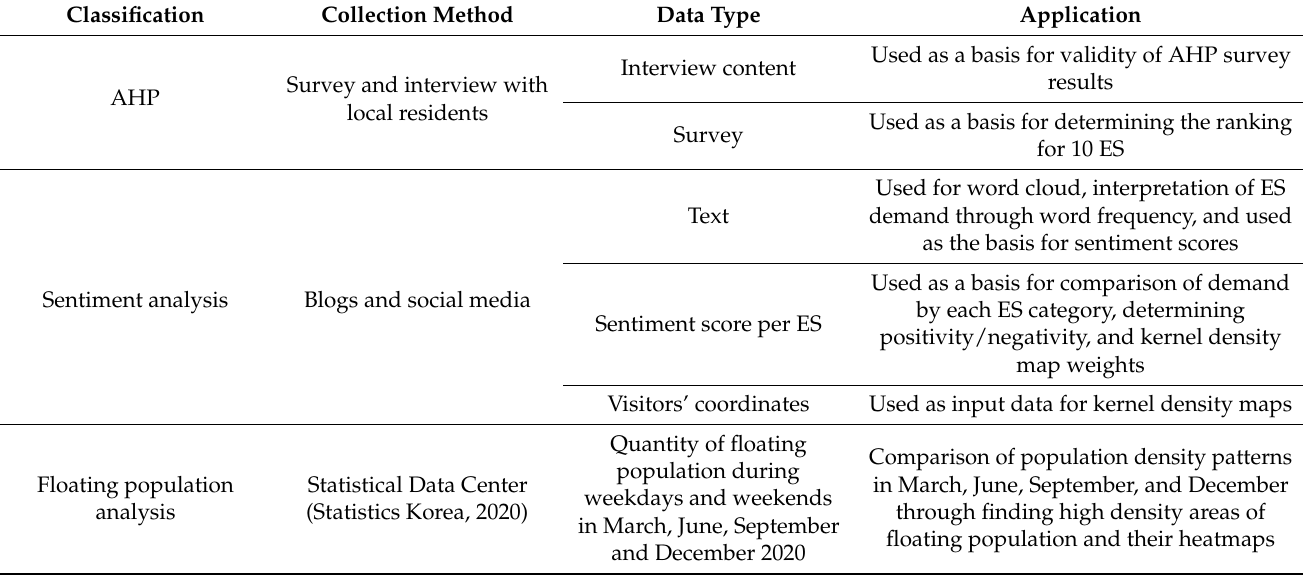
Table 3. Classification of the three methods and their